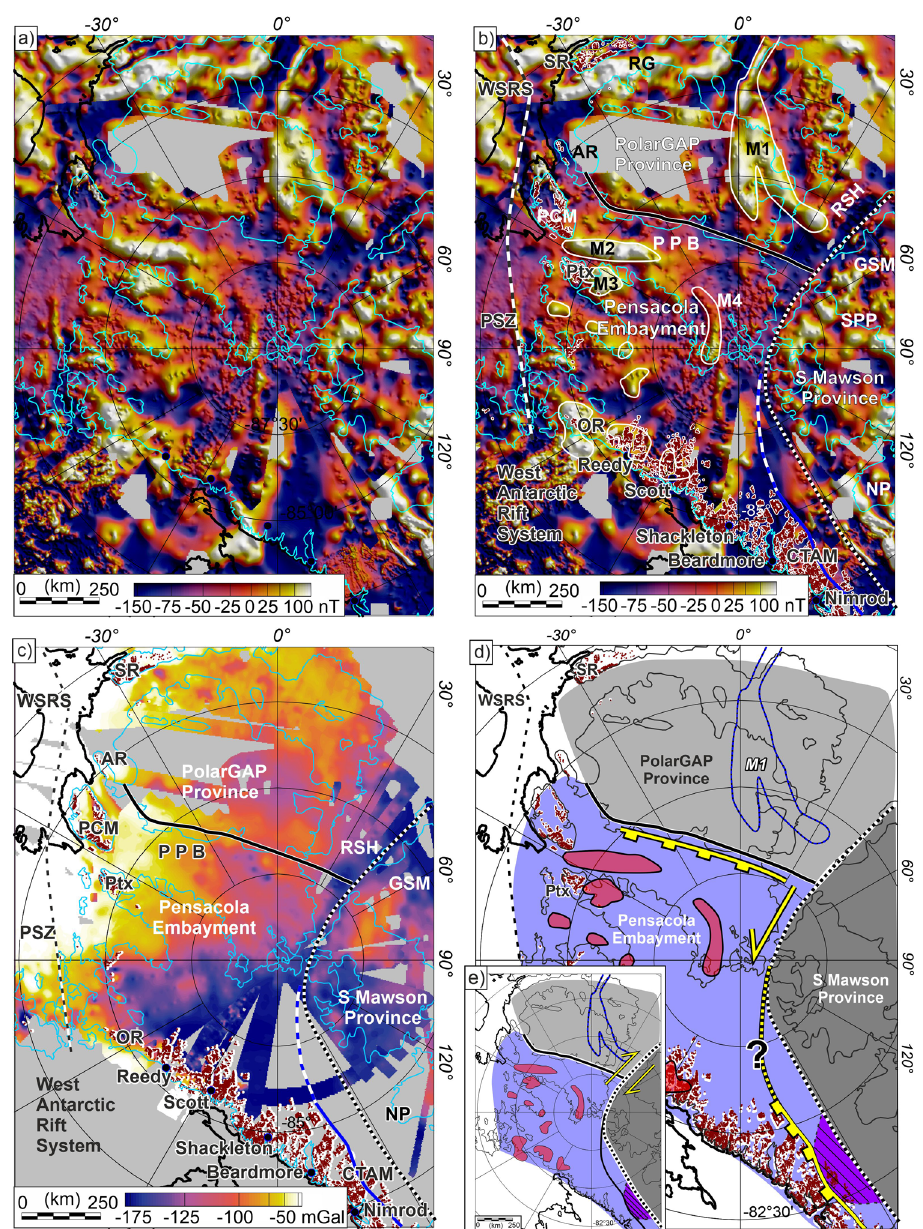
Fig. 2 Geophysical compilation and interpretation. a Magnetic anomaly map. Thin blue line is zero m elevation contour from Fig. 1b. b Annotated aeromagnetic anomaly map. Dotted black line marks edge of Southern Mawson Province. Solid black line separates Pensacola Embayment and PolarGAP Provinces. Blue line in CTAM marks exposed (solid) and inferred (dashed) edge of Archean rocks 20 . White outlines mark anomalies discussed in the text. Other features as in Fig. 1b. c Bouguer gravity anomaly map. d Preferred interpretive sketch. Basement provinces in grey and Pensacola Embayment in purple. Red bodies interpreted Ross intrusions. Yellow lines and arrows indicate Neoproterozoic rift margin segments and linking transfer fault. Note geometry of junction between CTAM rifted margin and proposed transfer fault (?) is unconstrained. e Alternative dextral model for formation of the Pensacola